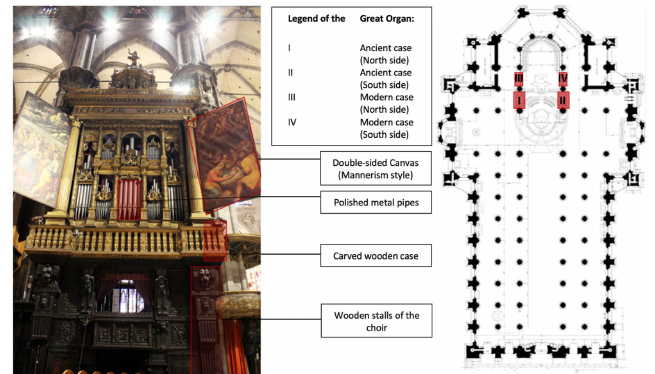
Figure 1. The Organo Maggiore with its main elements ( left ); the plan of the Milan Cathedral with the location of the musical instruments ( right ).